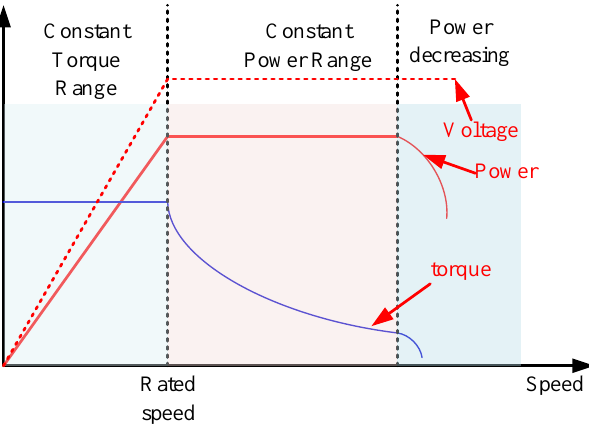
Figure 1. The operating speed range of PMSM.